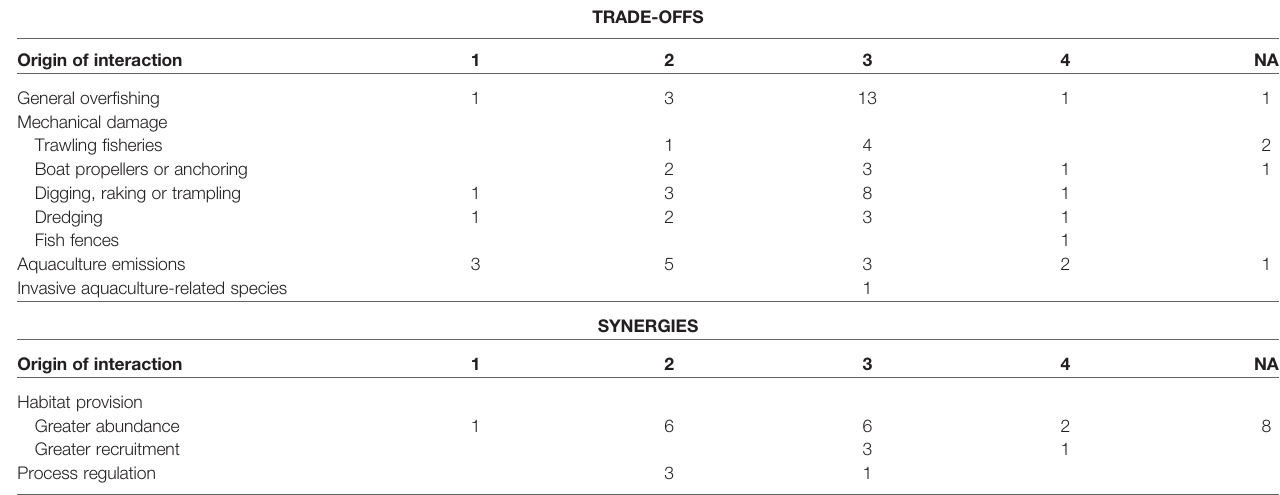
TABLE 2 | Summary of origin and magnitude of observed interactions in the literature synthesis (number of publications where a particular interaction and magnitude was observed).